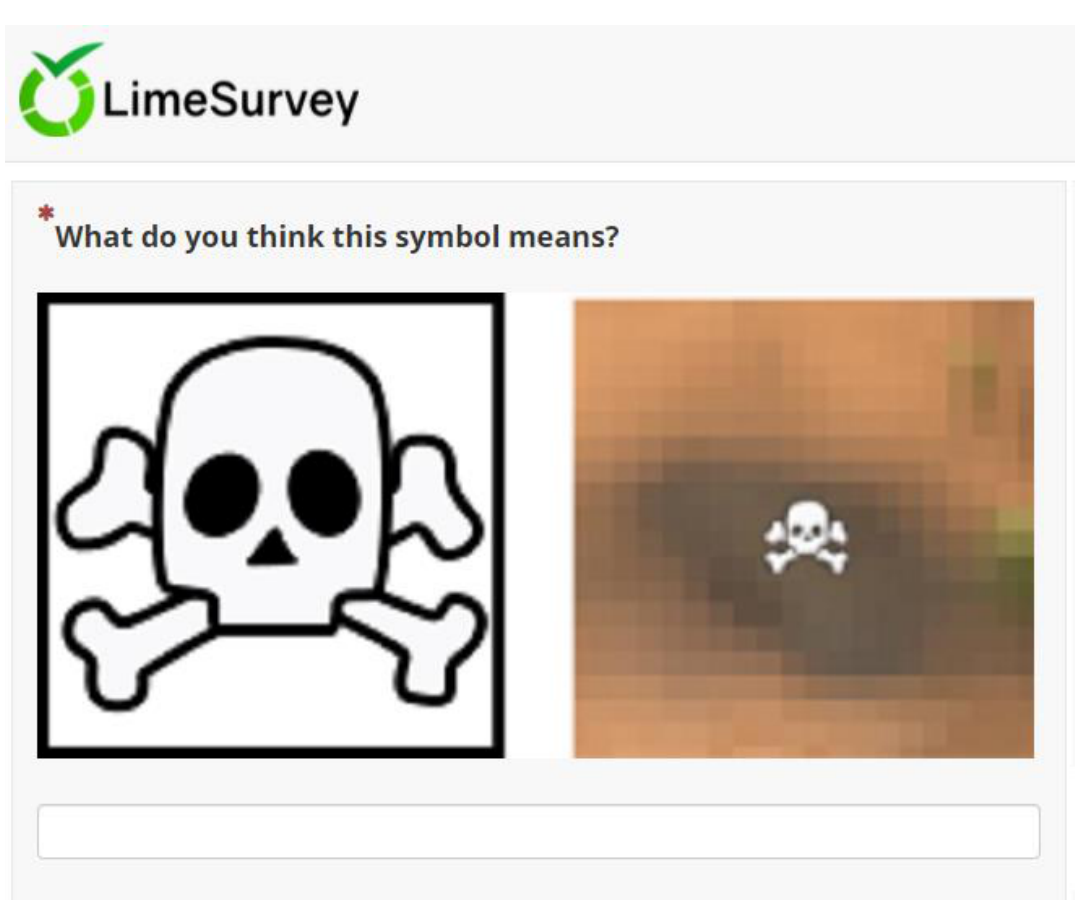
Figure 3. Online questionnaire on LimeSurvey platform.